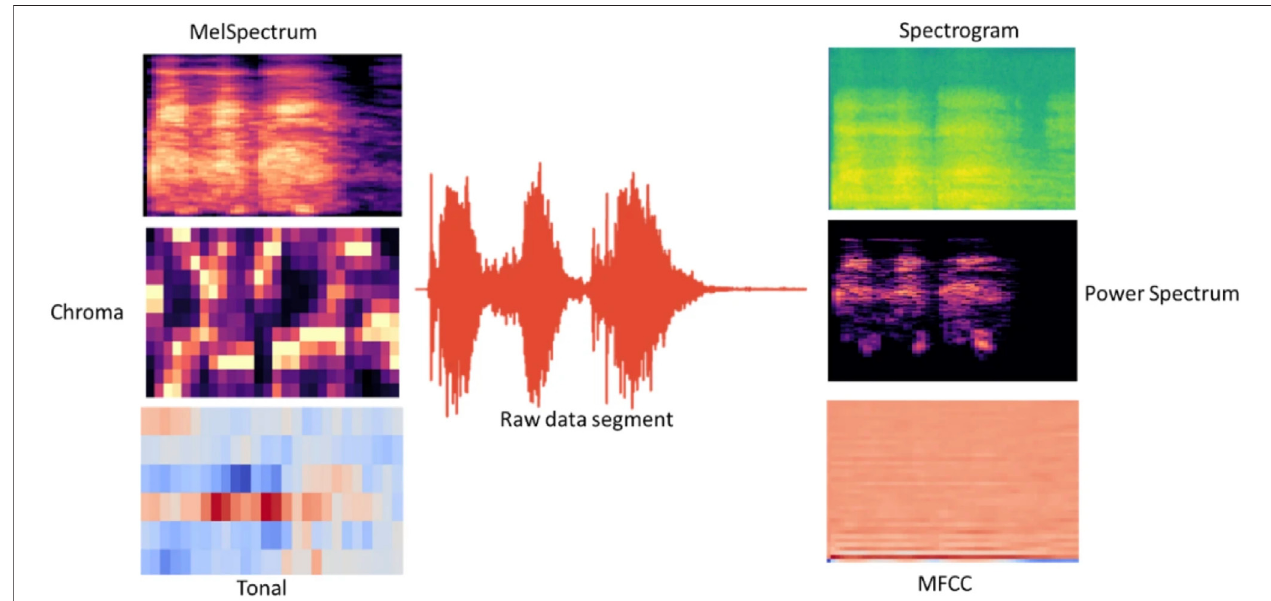
FIGURE2| Acoughaudioanditssixrepresentations:theMelSpectrum,chroma,tonal,spectrogram,powerspectrum,andMFCC,accordingtoMohammedetal. (2021). The cough undergoes an audio splitting step, generating six frequency measures based on the Mel frequency scale. These are audio signal representations based on frequency. These representations are used in neural networks. MFCC stands for Mel Frequency Cepstral Coef fi cients.